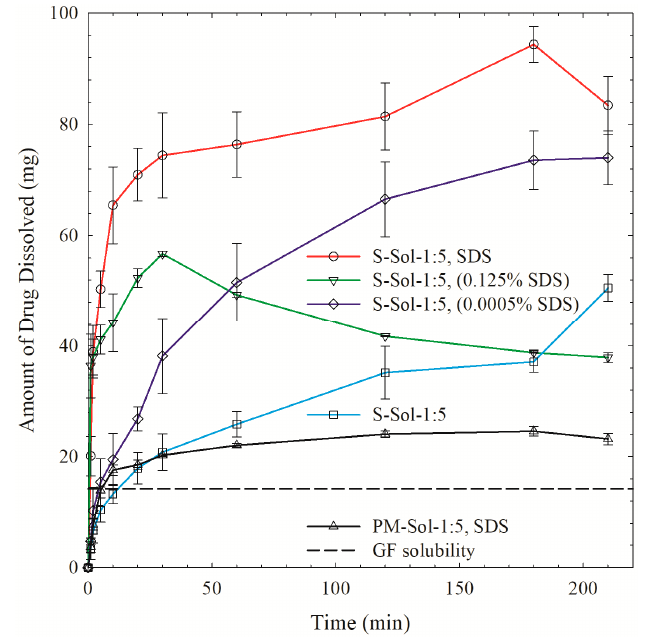
Figure 10. Evolution of GF release from a physical mixture (PM) with Sol–SDS and spray-dried powders prepared using the GF solution with a 1:5 GF:Sol mass ratio and with / without SDS in the formulation. Deionized water was used as the dissolution medium for the formulation with SDS (S-Sol-1:5, SDS) and the physical mixture. For the formulation without SDS (S-Sol-1:5), an aqueous solution of 0.125% w / v SDS, aqueous solution of 0.0005% w / v SDS, and deionized water were used as dissolution media.